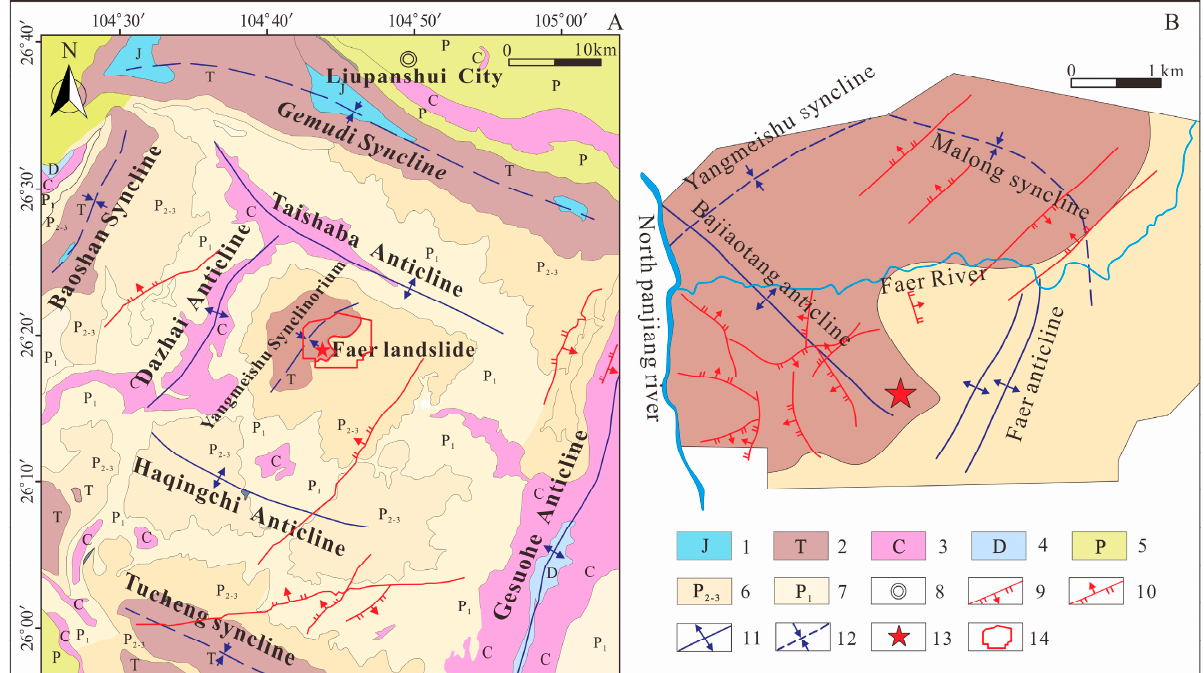
Figure 2. ( A ) Geological structure of the study area and ( B ) geological structure of the Faer coal mine (1. Jurassic; 2. Triassic; 3. Carboni; 4. Devonian; 5. Permian; 6. Middle-Upper Permian; 7.